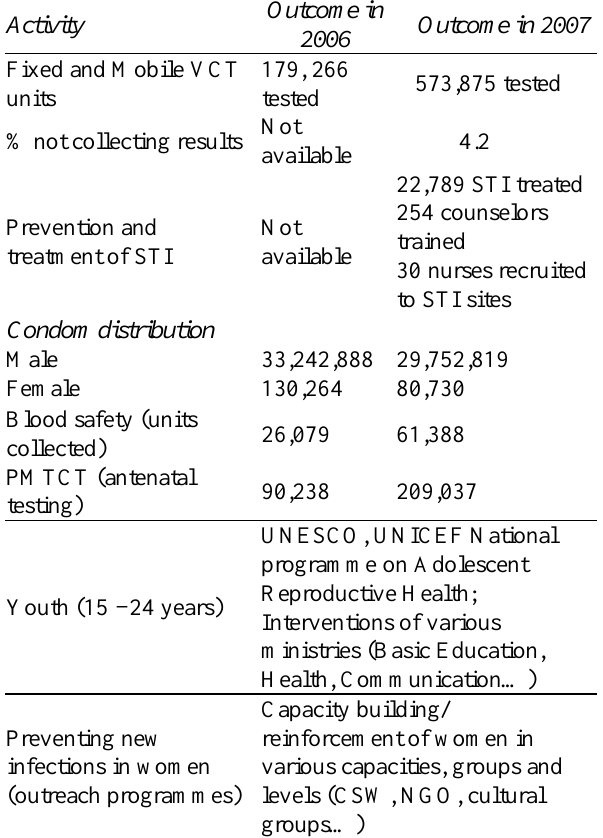
Table 1: Access to Prevention of HIV infection in Cameroon (CSW=commercial sex workers; NGO= non- governmental organizations).